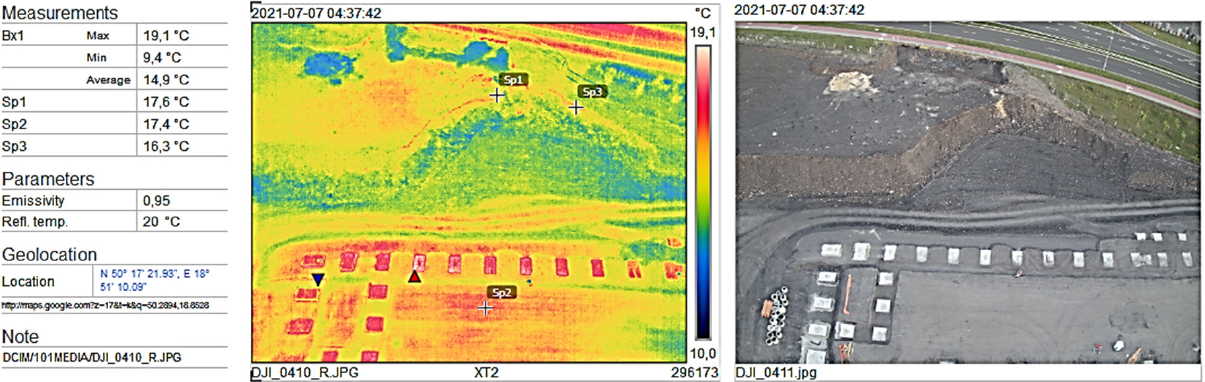
Figure 12. Infrared and visible light imaging—southern part of the construction site (own elaboration).